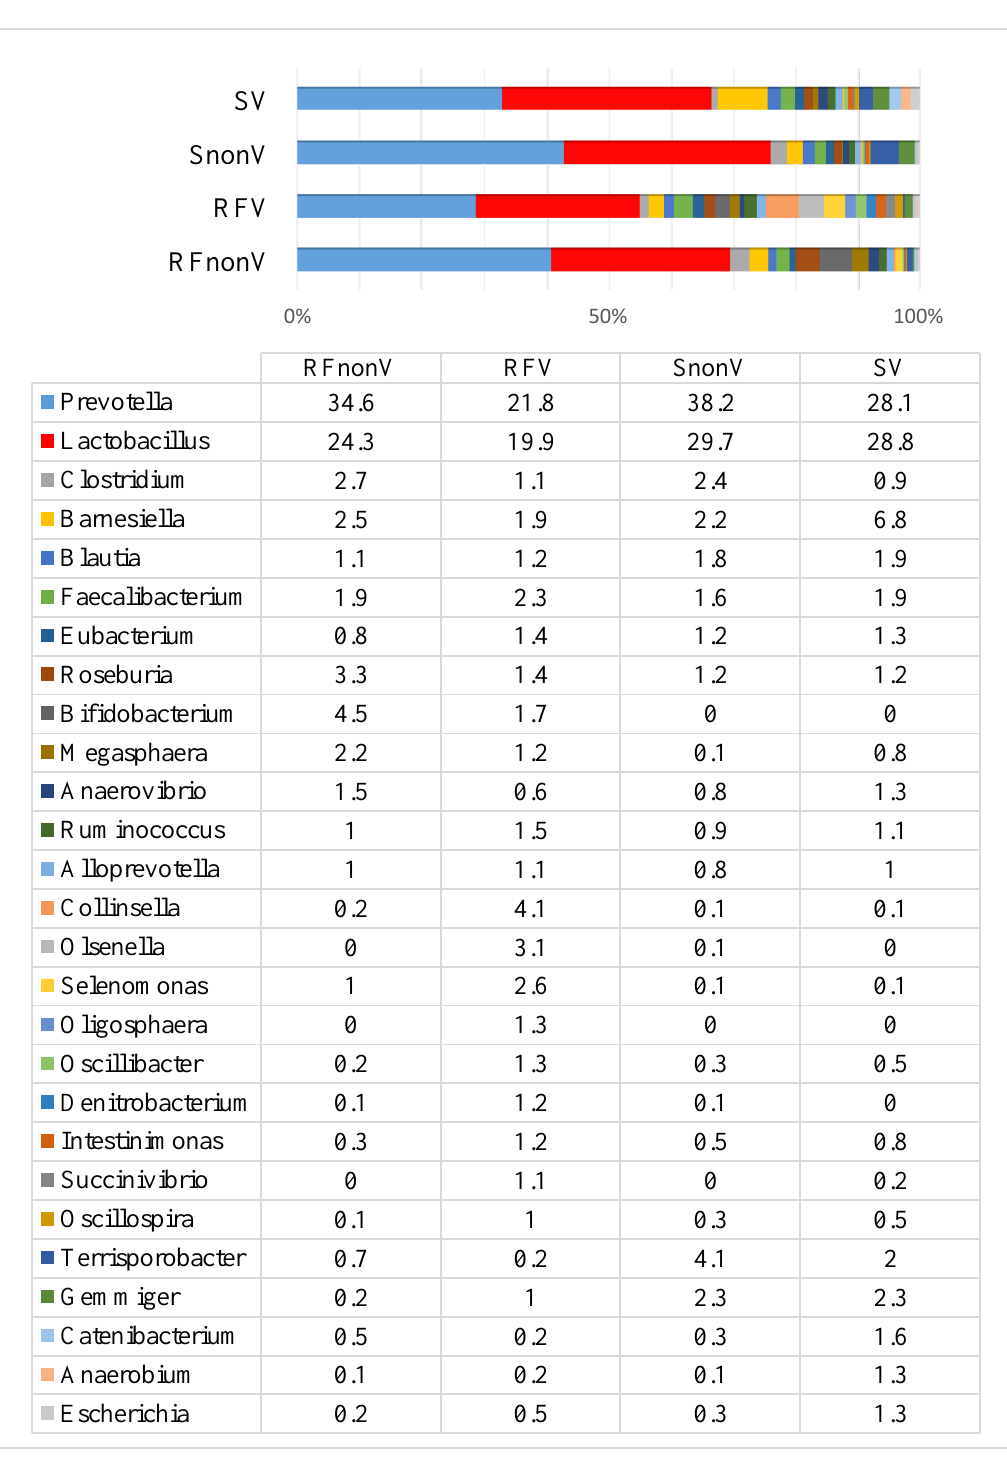
Figure 2. Microbial profiles (prevalence, %) at the genus level in pig faeces before the experiment.